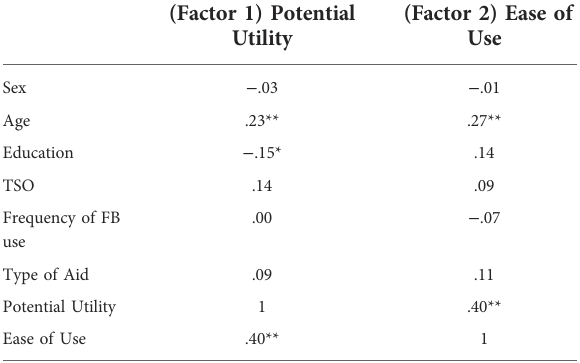
TABLE 8 Pearson correlation table among